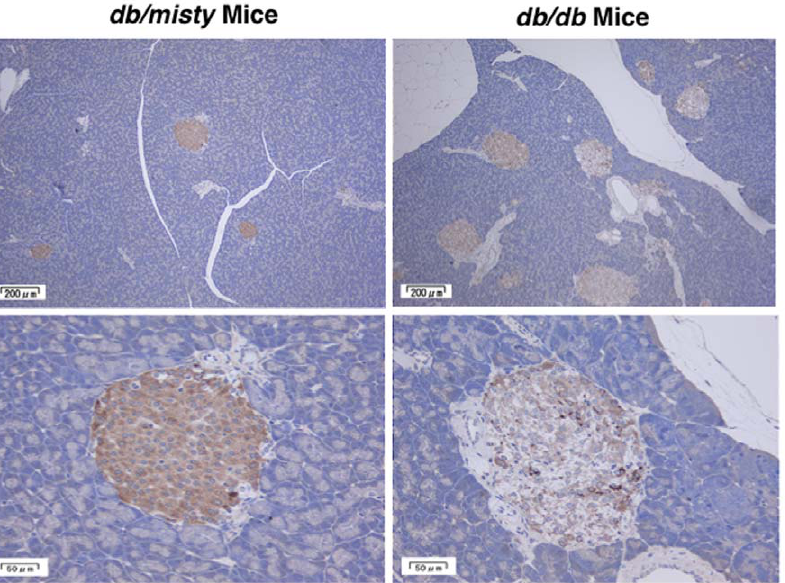
Figure 6. Expression of GIPR in pancreatic islets from db/misty and db/db mice. GIPR was stained with goat polyclonal anti-GIPR antibody. Hematoxylin was used for nuclear staining. Representative results are